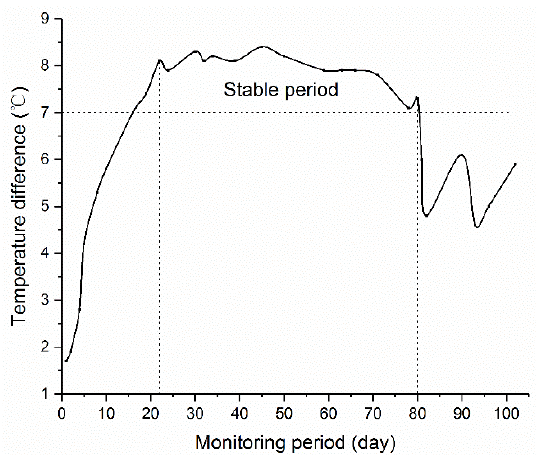
Figure 9. Temperature difference diagram between the bottom center of the XPS plates and the corresponding position of the common subgrade.